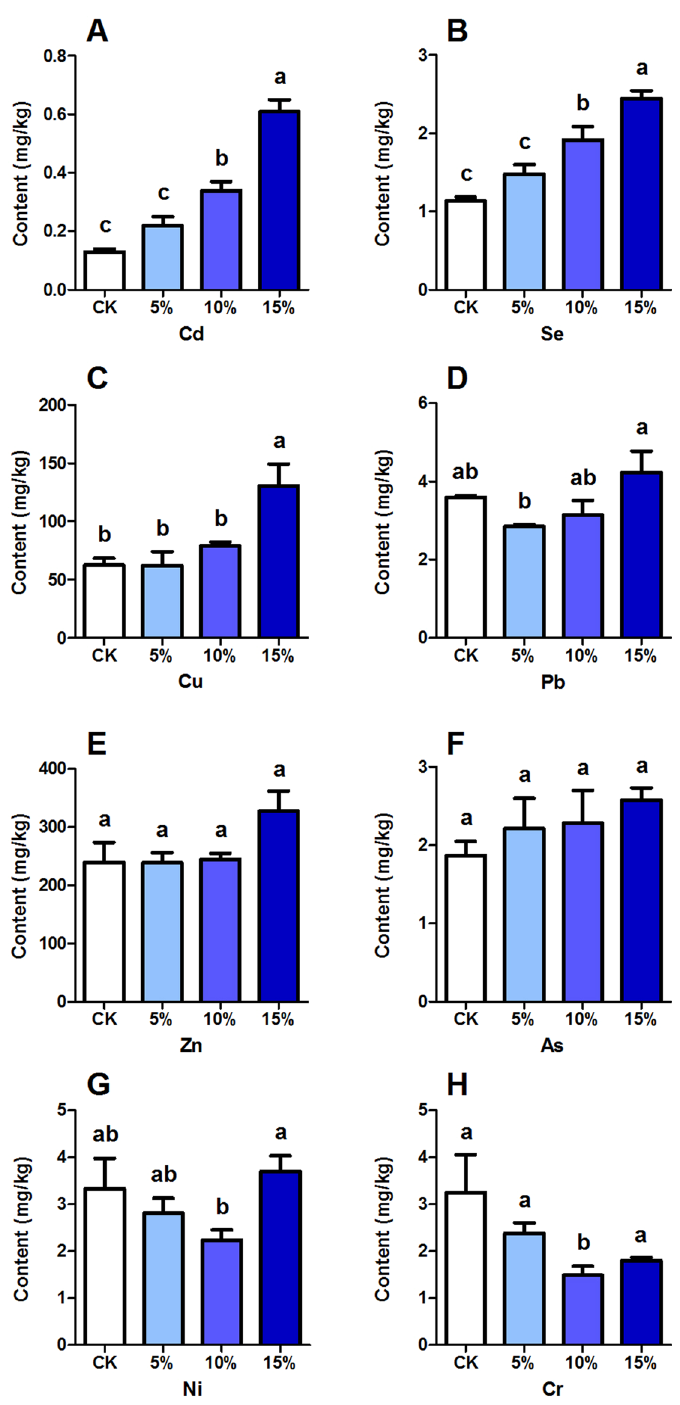
Figure 3. Heavy metal concentrations in the faeces of chickens fed with maggot meal. The x-axis in all plots shows the proportions of maggots added into the feed (0%, 5%, 10% and 15%). CK represents meal feed for chickens without maggot addition. Data are means ± SEM (n = 3). Different letters on each column indicate significant differences between treatments at P < 0.05 during different